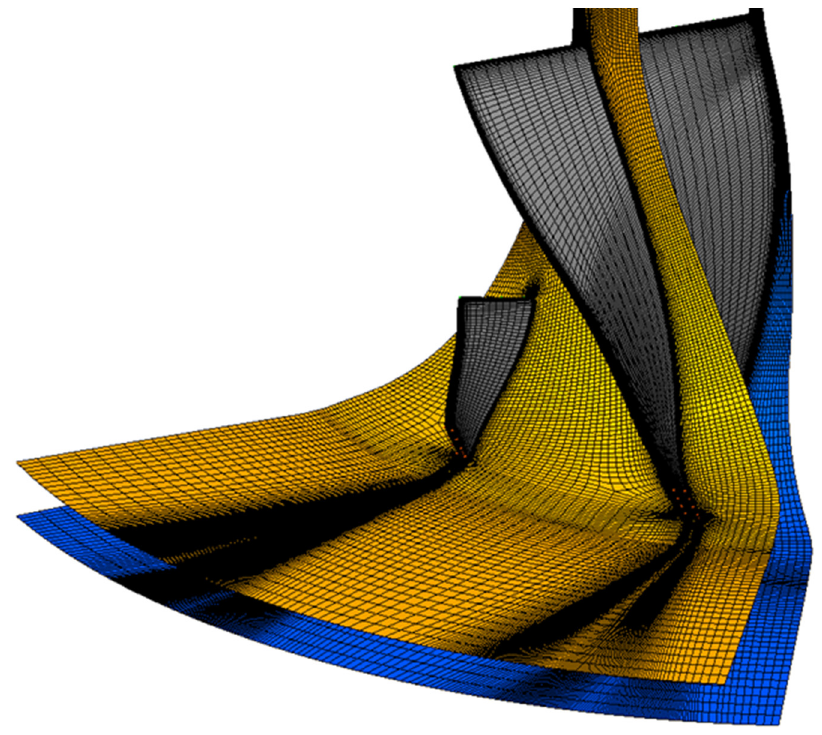
Figure 2. Mesh of a portion of the stage.